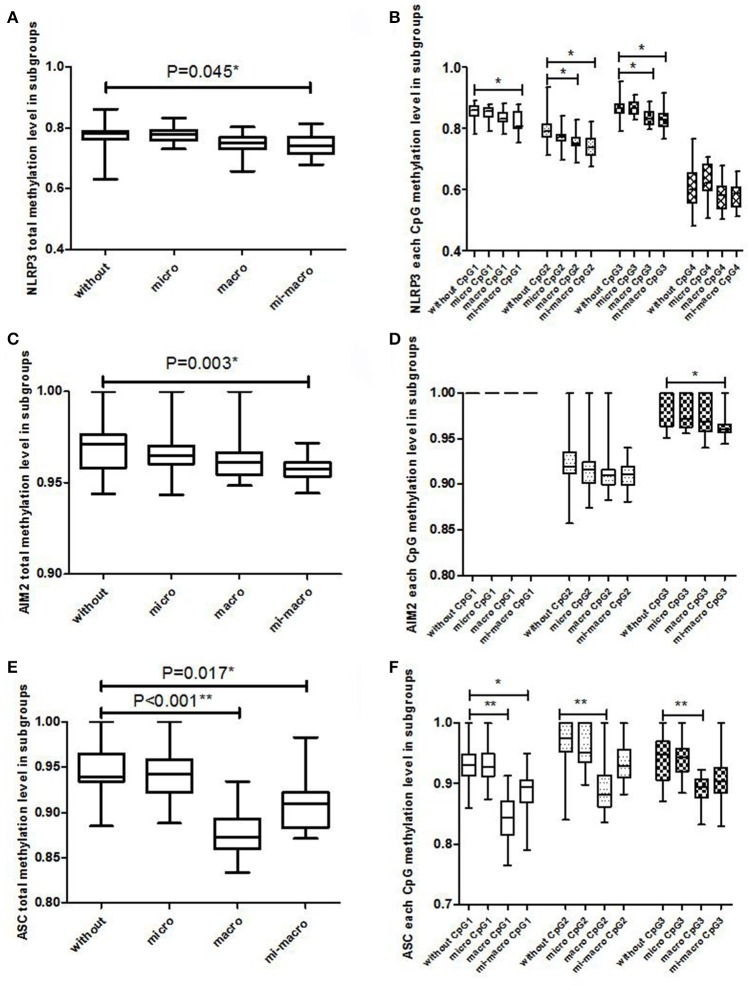
The association between promoter methylation in NLRP3, AIM2, and ASC genes and T2DM complication (T2DM without any complication vs. T2DM with microvascular complications; T2DM without any complication vs. T2DM with macrovascular complications; T2DM without any complication vs. T2DM with both microvascular and macrovascular complications). (A) NLRP3 total methylation level; (B) NLRP3 each CpG methylation level; (C) AIM2 total methylation level; (D) AIM2 each CpG methylation level; (E) ASC total methylation level; (F) ASC each CpG methylation level. The Kruskal-Wallis test was used among T2DM subgroups and a Dunn-Bonferroni test for post-hoc comparisons, * Bonferroni-corrected P < 0.05, ** Bonferroni-corrected P < 0.001.